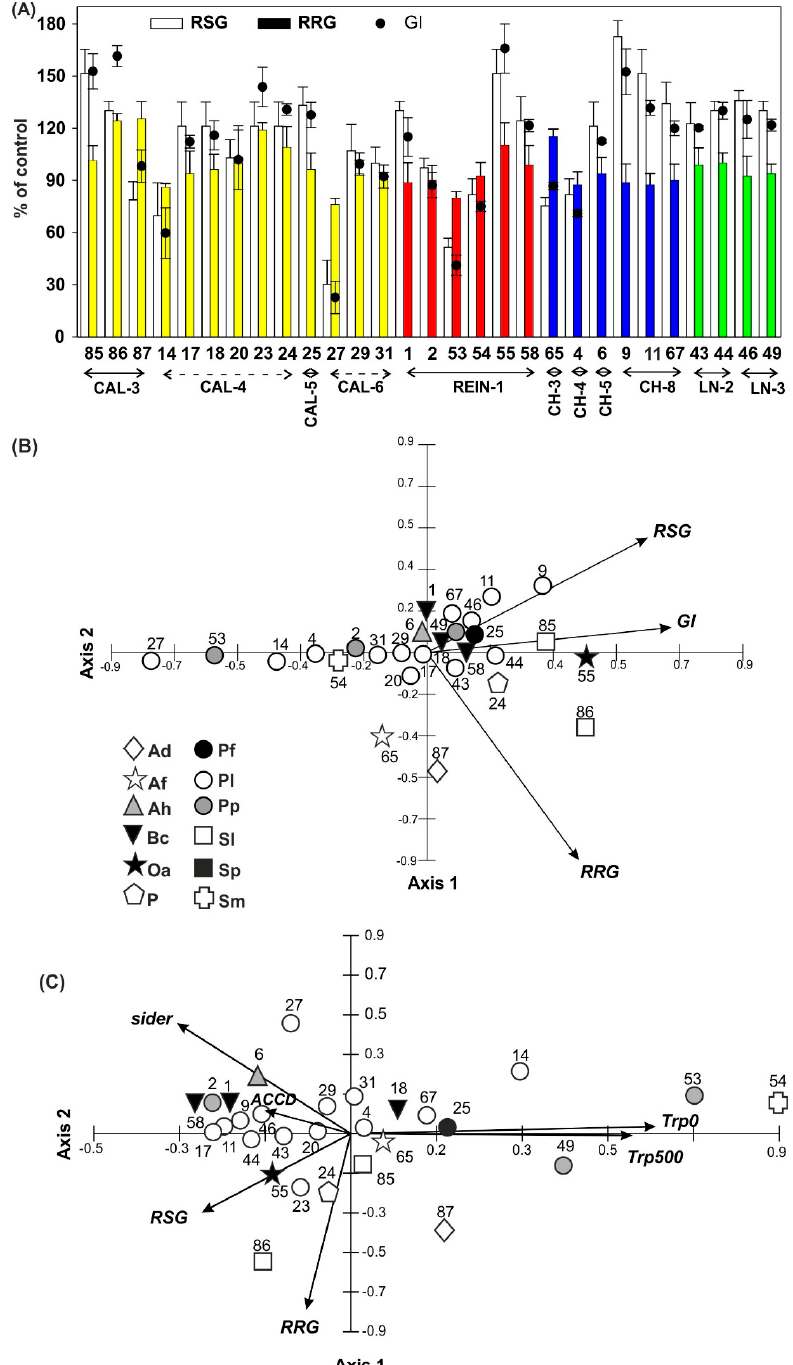
Figure 8. Seeds germination (RSG), root length (RRG), and germination index (GI) of Phaseolus coccineus ( A ). PCA for germination parameters: RSG, RRG, GI ( B ), and PCA for ACCD activity, IAA concentration with Trp0 and Trp500, RSG, RRG, and presence of siderophores (sider) ( C ). For other abbreviations, please see Table 1.